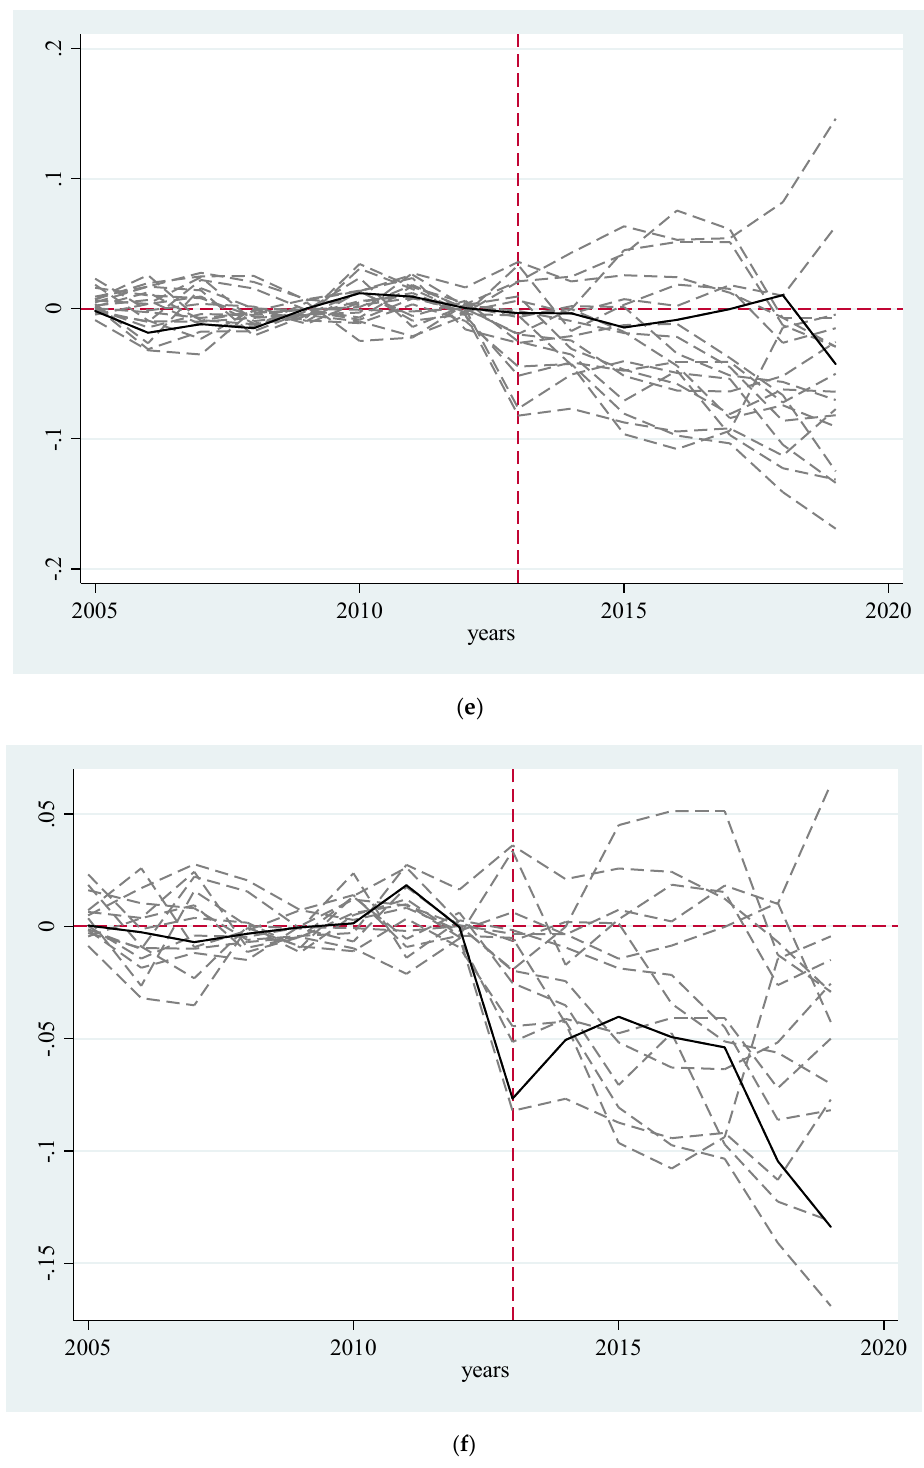
Figure 3. Distribution of carbon emission difference between carbon trading pilot provinces and other provinces. ( a ) Beijing; ( b ) Tianjin; ( c ) Shanghai; ( d ) Hubei; ( e ) Guangdong; ( f ) Chongqing.